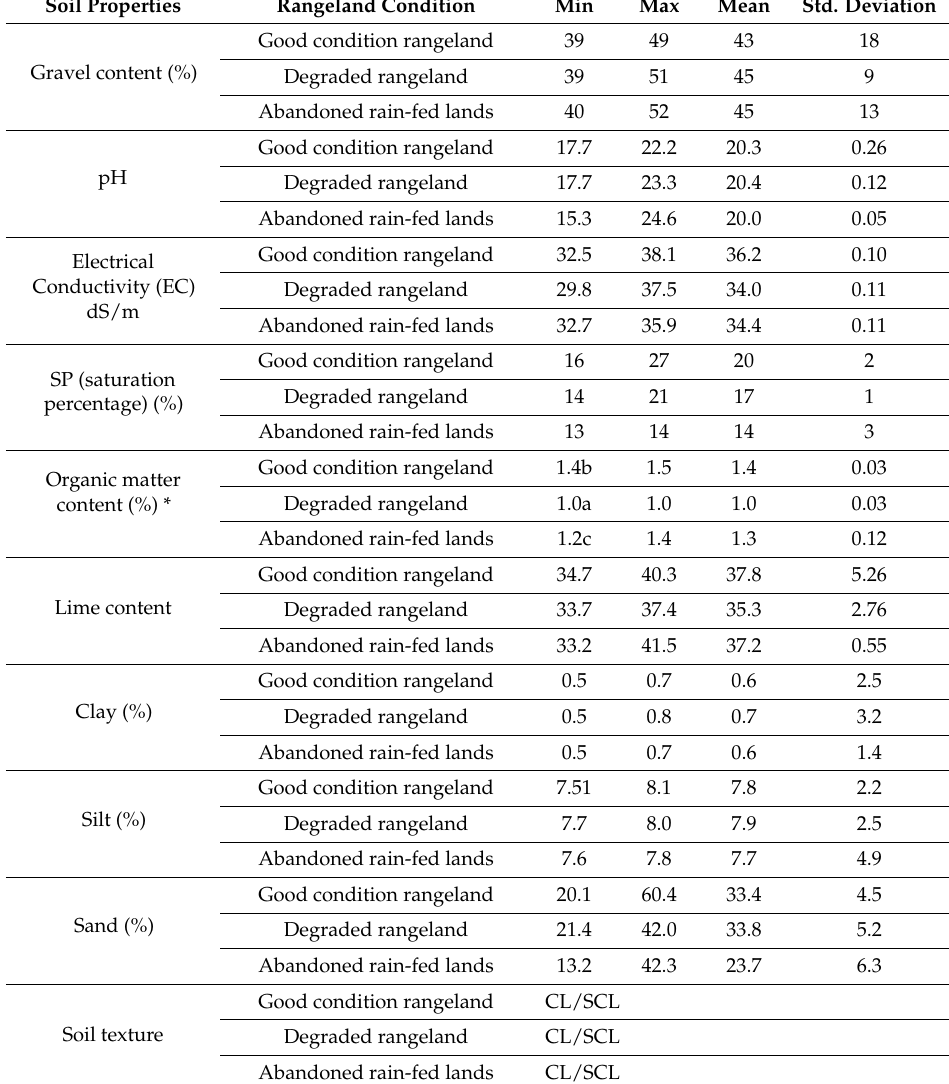
Table 2. Soil properties of the studied sites at the depth of 0–30 cm